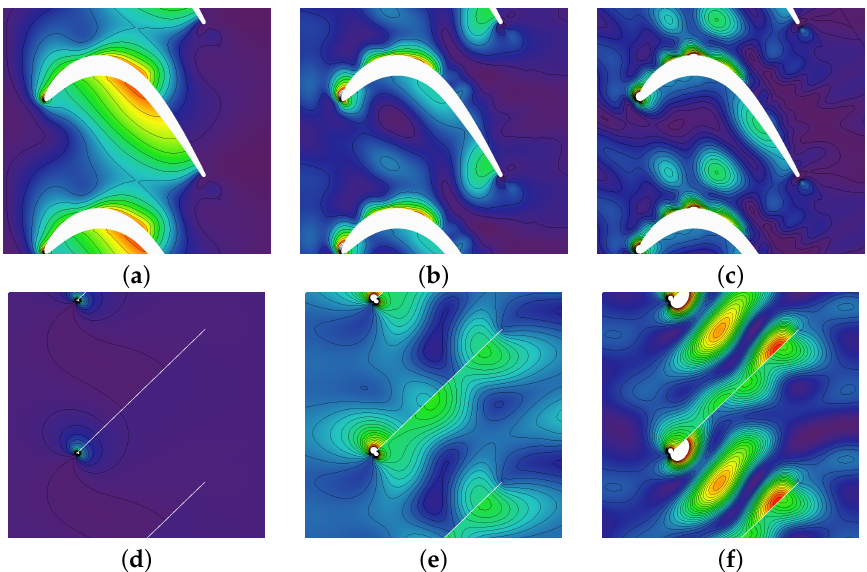
Figure 6. Pressure RMS at different reduced frequencies, with M 1 = 0.42. ( a – c ): Actual airfoil. ( d – f ): Flat Plate. ( a , d ): f red = 3; ( b , e ): f red = 15; ( c , f ): f red = 21. A different colour scale is used in each